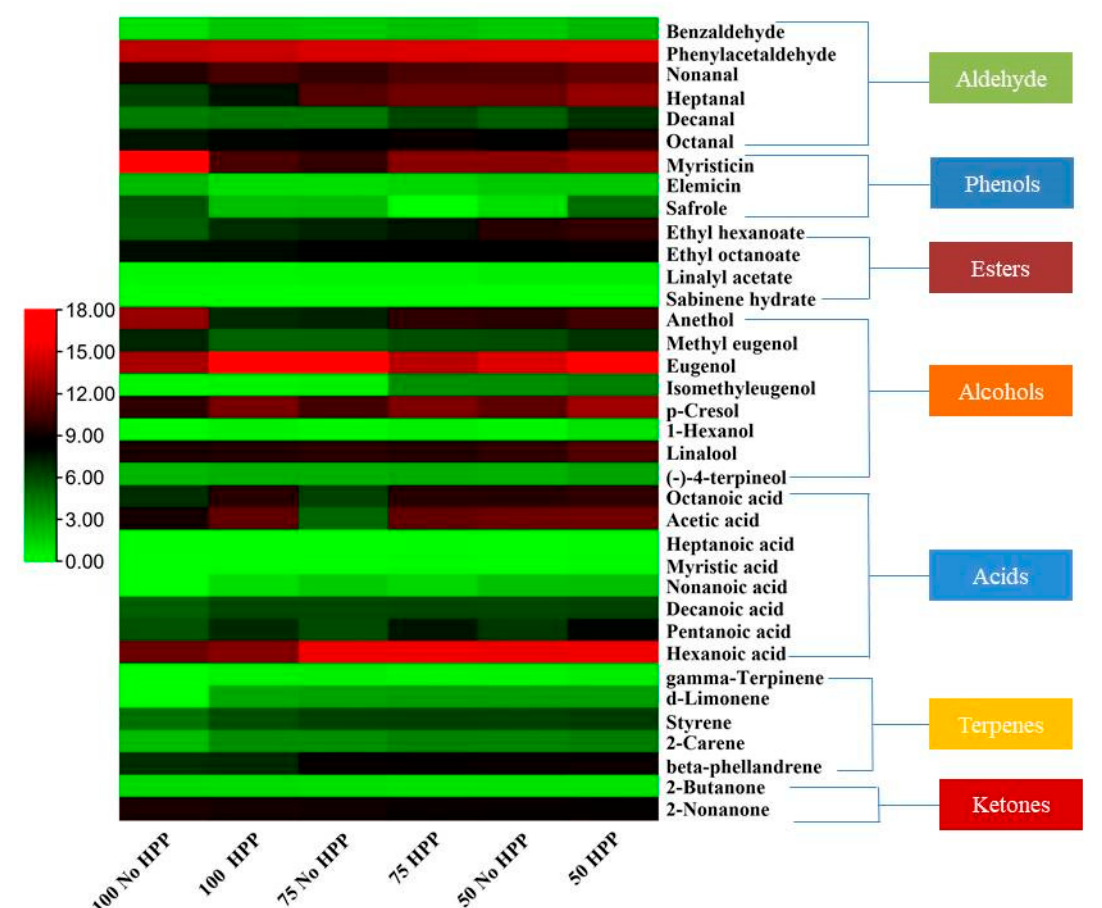
Figure 6. Heat map of odor activity values (OAVs) of volatile compounds in sausages refrigerated for 28 days with partial substitution of NaCl by KCl at 0%, 25%, and 50% with HPP treatment. The color scale indicates the intensity of the OAV.